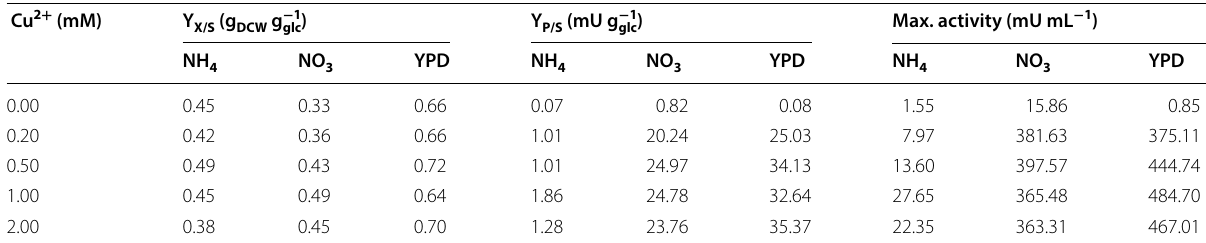
Table 1 Summary of the specific yields obtained during the analysis of Tvlcc5 synthesis by A. adeninivorans